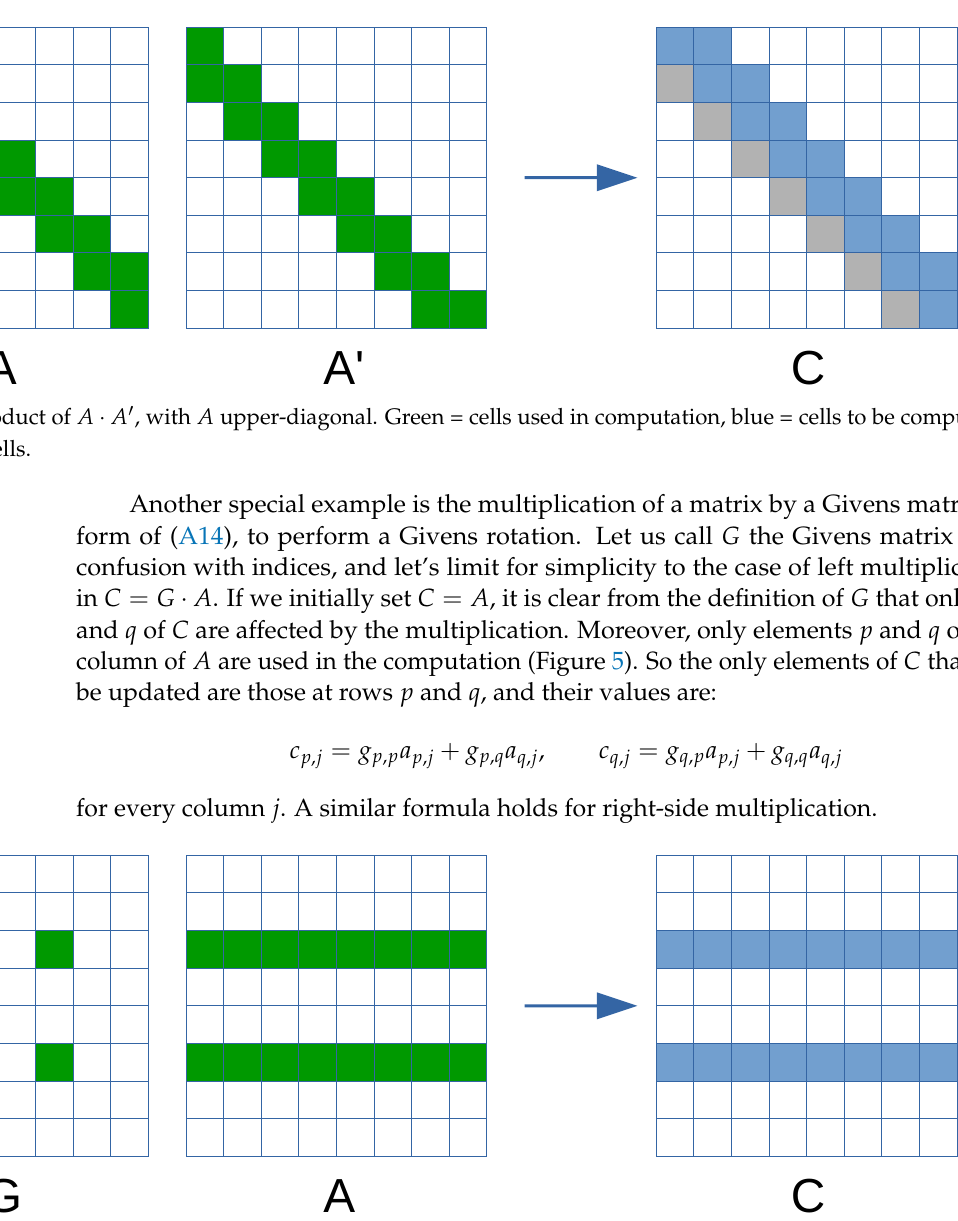
Figure 5. Matrix product for Givens rotation. Green = cells used in computation, blue = cells to be computed.